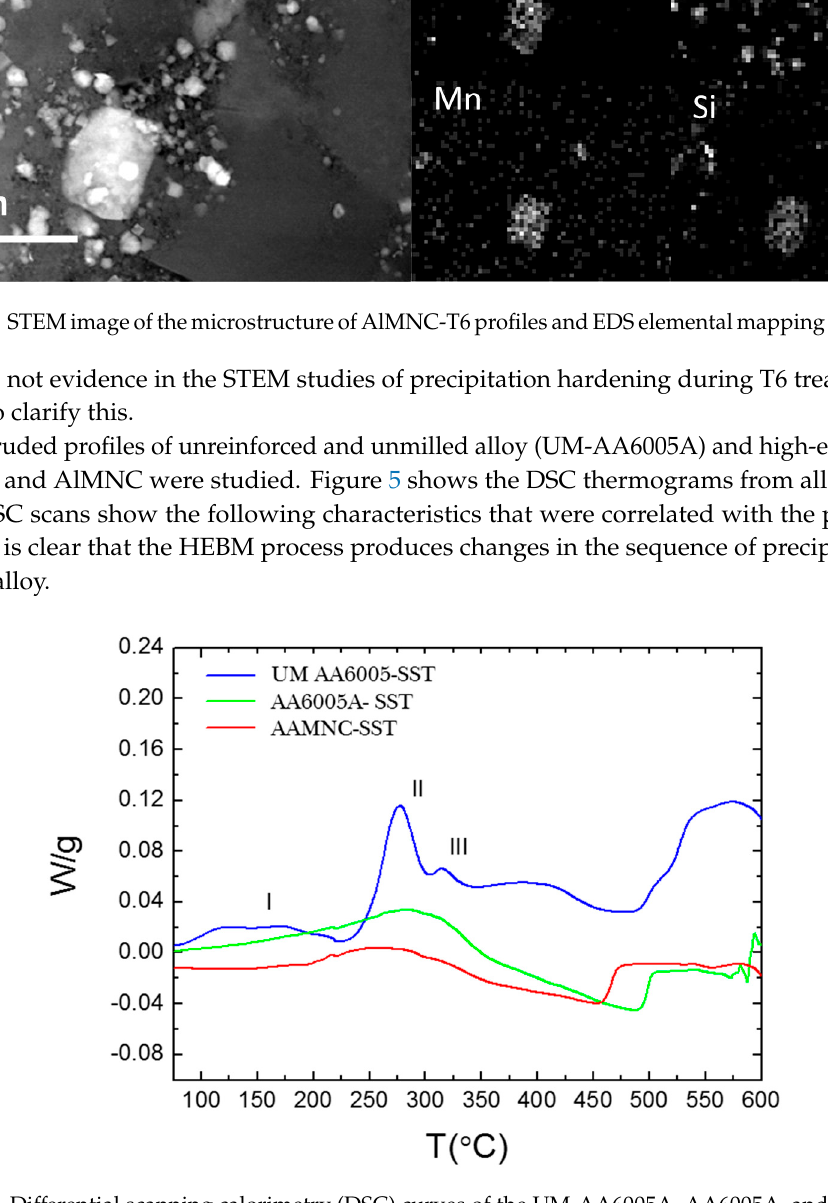
Figure 5. Di ff erential scanning calorimetry (DSC) curves of the UM-AA6005A, AA6005A, and AlMNC Figure 5. Differential scanning calorimetry (DSC) curves of the UM ‐ AA6005A, AA6005A, and extruded profiles after solid-solution treatment AlMNC extruded profiles after solid ‐ solution treatment (SST).